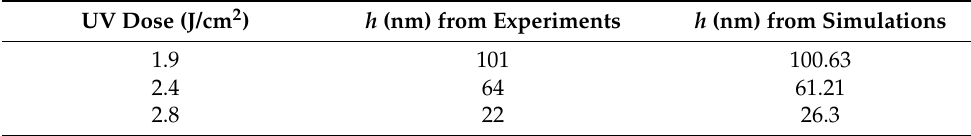
Table 2. Comparison of the experimental and the best-fitting simulation